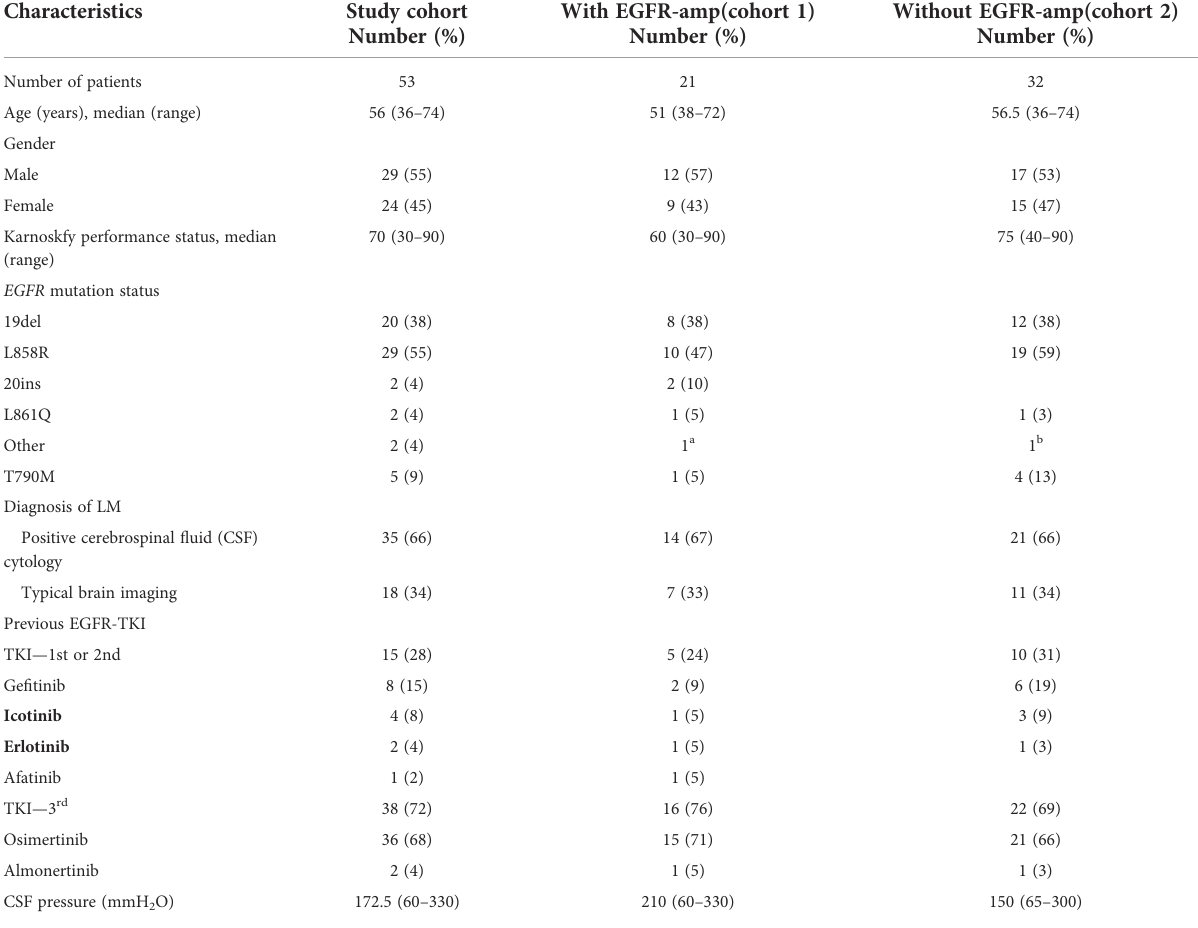
TABLE 1 Clinical characteristics of 53 non-small cell lung cancer – leptomeningeal metastases (LM) patients with EGFR mutation.